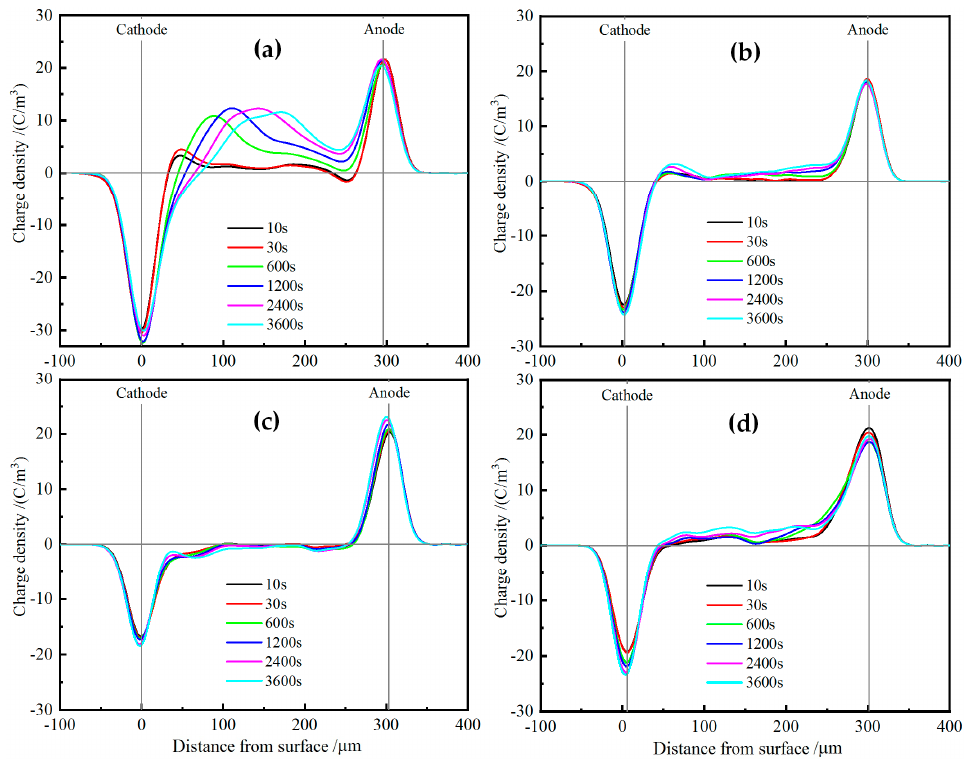
Figure 11. Space charge distributions in ( a ) pure XLPE and the nanocomposites of ( b ) 0.5wt%TAIC- s -SiO 2 /XLPE, ( c ) 1.5wt%TAIC- s -SiO 2 /XLPE and ( d ) 2.0wt%TAIC- s -SiO 2 /XLPE under DC electric field of 40 kV/mm at 80 °C.